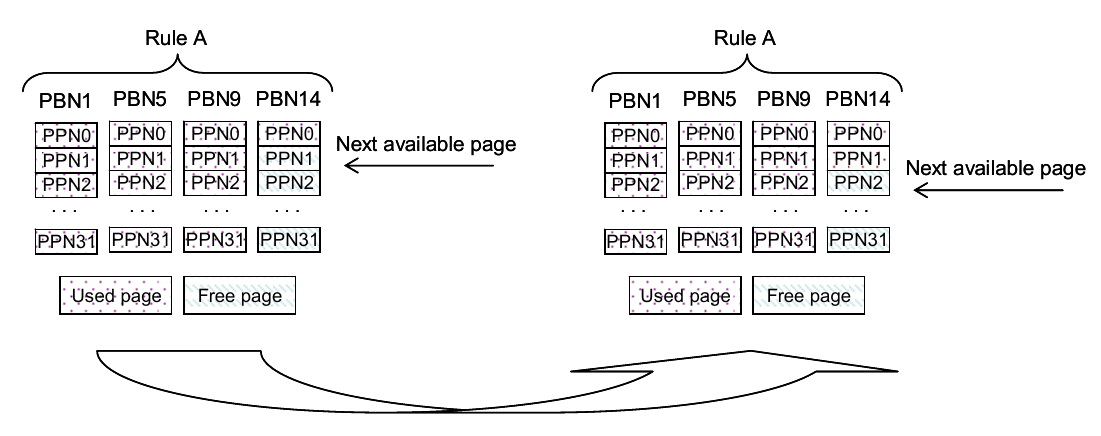
Figure 5. Sequential incremental page